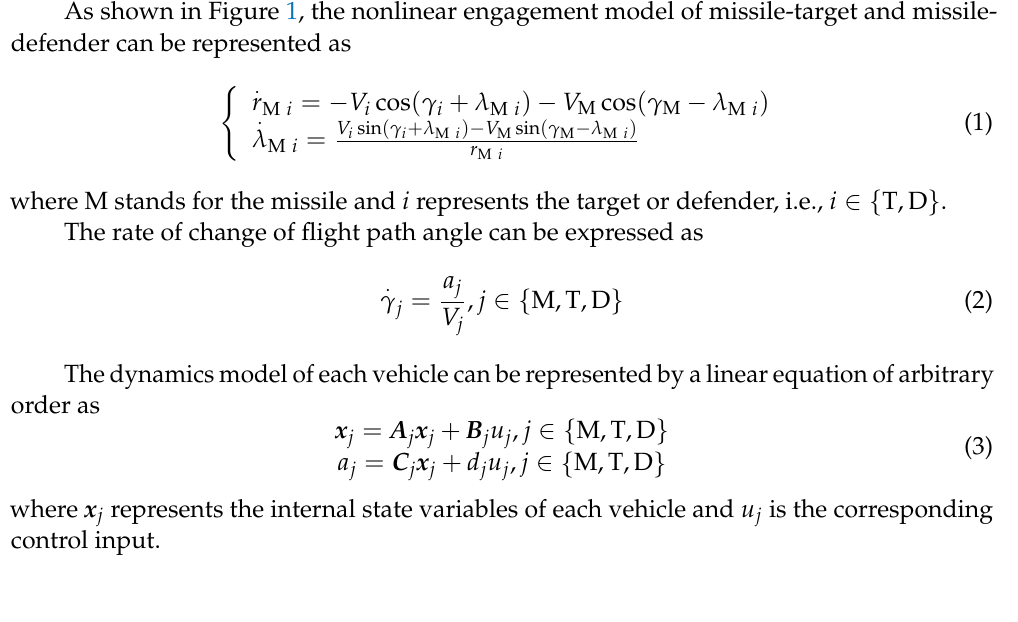
where x j represents the internal state variables of each vehicle and u j is the corresponding control